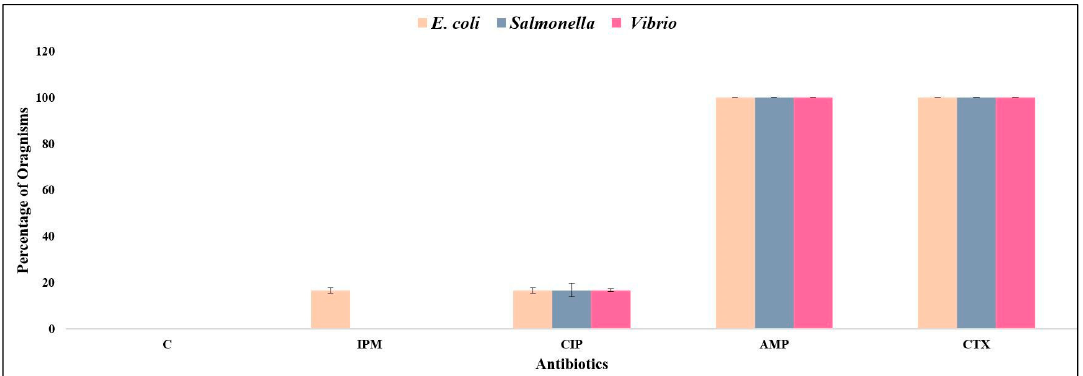
Figure 2. Antimicrobial resistance (AMR) for five different antibiotics (C—chloramphenicol, IPM—imipenem, CIP—ciprofloxacin, AMP—ampicillin, CTX—cefotaxime) in three pathogenic bacteria.